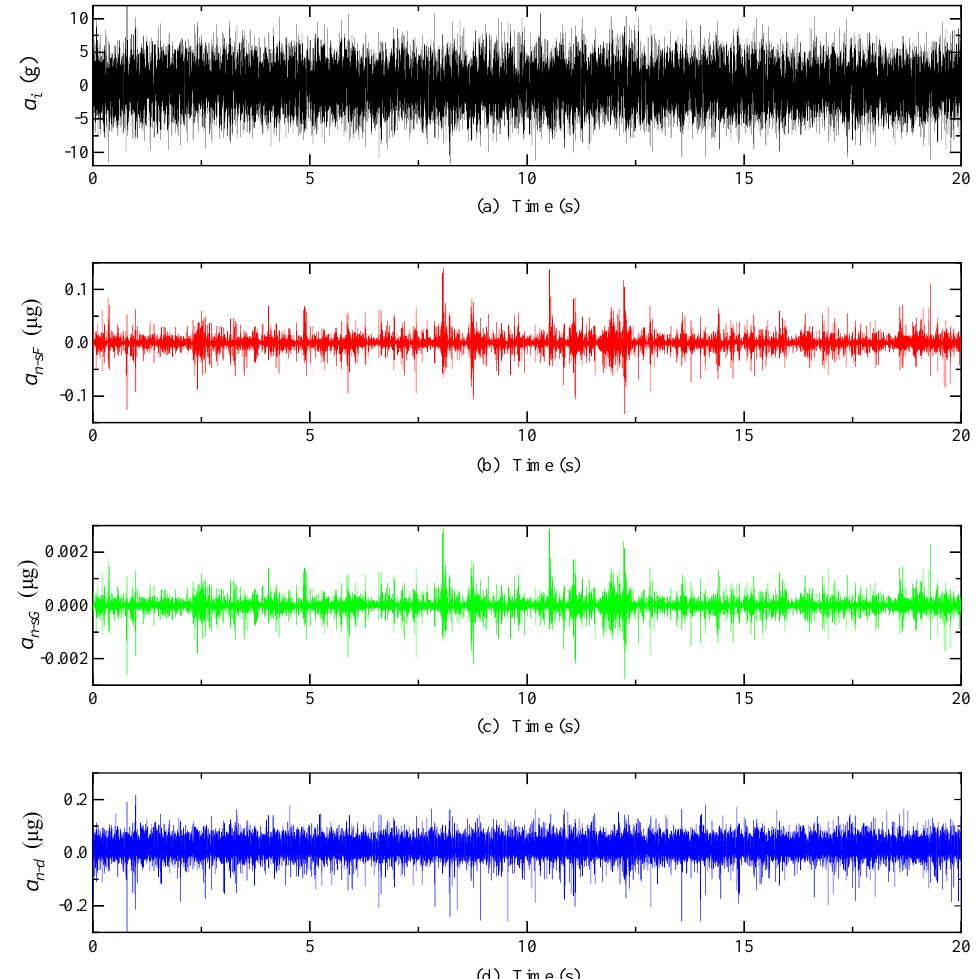
Figure 18. Simulation results of electric field coupling detection noise after optimization. ( a ) Input acceleration; ( b ) The detection noise equivalent acceleration of the SCM detection circuit when the float shell is used; ( c ) The detection noise equivalent acceleration of the SCM detection circuit when the shell is grounded; ( d ) The detection noise equivalent acceleration of the DCM detection